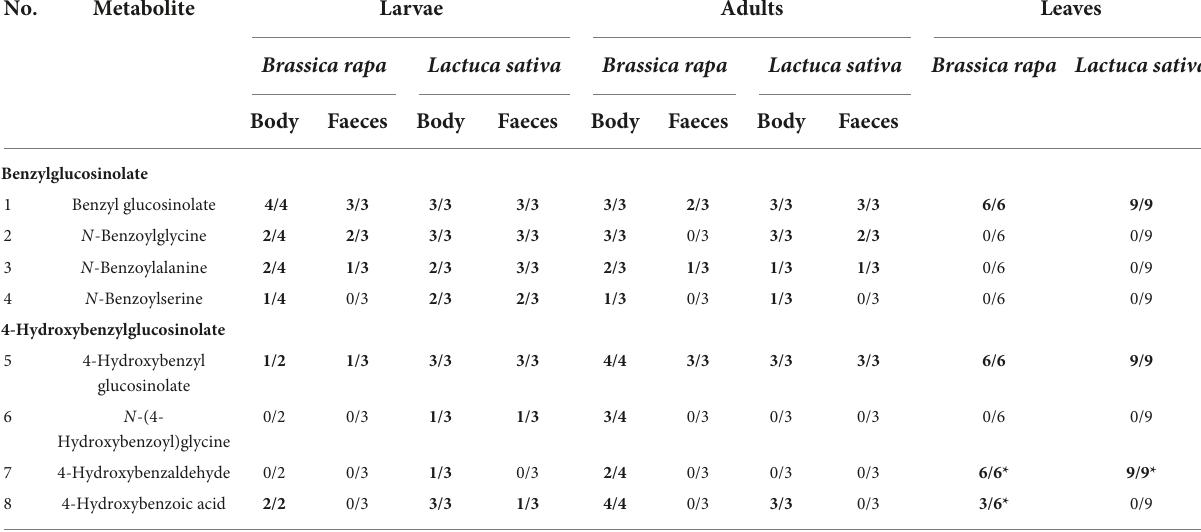
TABLE 2 Numbers of insect body and faecal samples from larvae and adults of Galeruca tanaceti (out of 2–4 replicates) and leaf samples in which the glucosinolates (highlighted in bold) and their putative breakdown metabolites were found by UHPLC-DAD-QTOF-MS/MS.